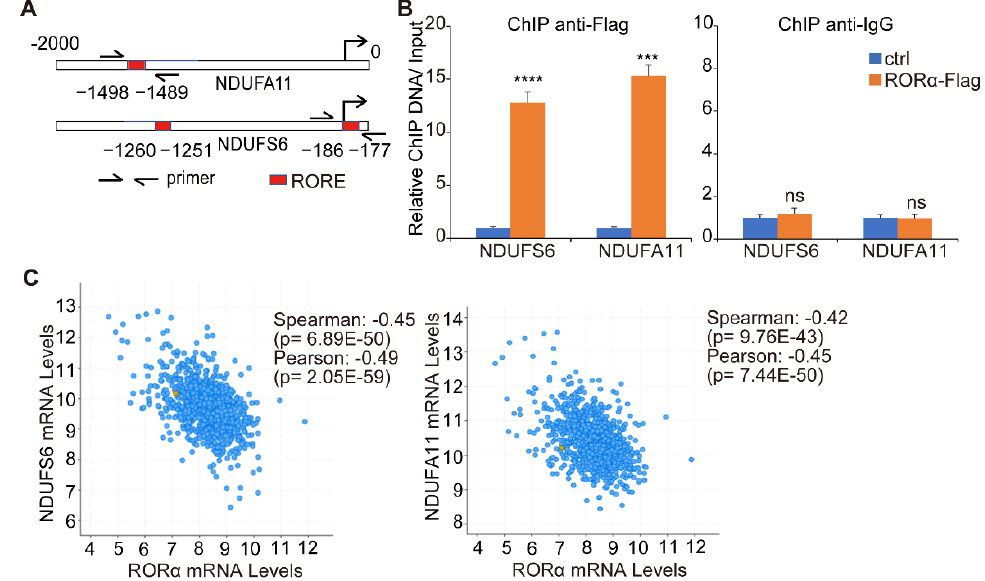
Figure 4. ROR α binds to ROREs in NDUFS6 and NDUFA11 promoter regions. ( A ) Scheme showing the potential RORE in NDAFS6 and NDAUFA11 genes. The red box represents potential RORE in their ~2000 bp promoter regions. ( B ) Bar graph showing the relative ChIP DNA enrichment in control and ROR α -overexpression MDA-MB-231 cells. After normalization to input, the relative enrichment of ChIP DNA was calculated in both groups by dividing with the value of the control group; results are presented as mean ± SEM; n = 4, **** p < 0.0001, *** p < 0.001, student’s t -tests. ( C ) Dot plots showing the negative correlation between mRNA levels of NDUFS6 or NDUFA11 and ROR α expression in human breast cancer tissues (gene expression data were derived from the TCGA breast cancer dataset).